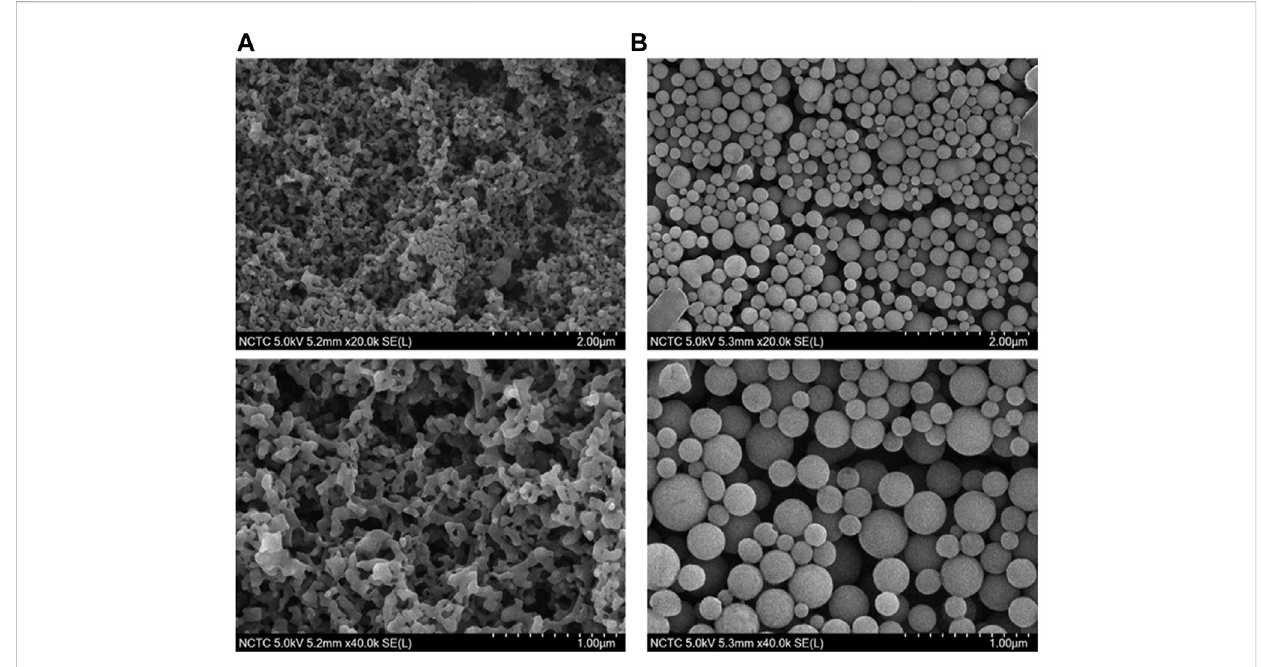
FIGURE 6 Morphology of organosolv lignin precipitated by solvent dilution at 17.5%v/v ethanol (A) and 35.0%v/v ethanol (B)